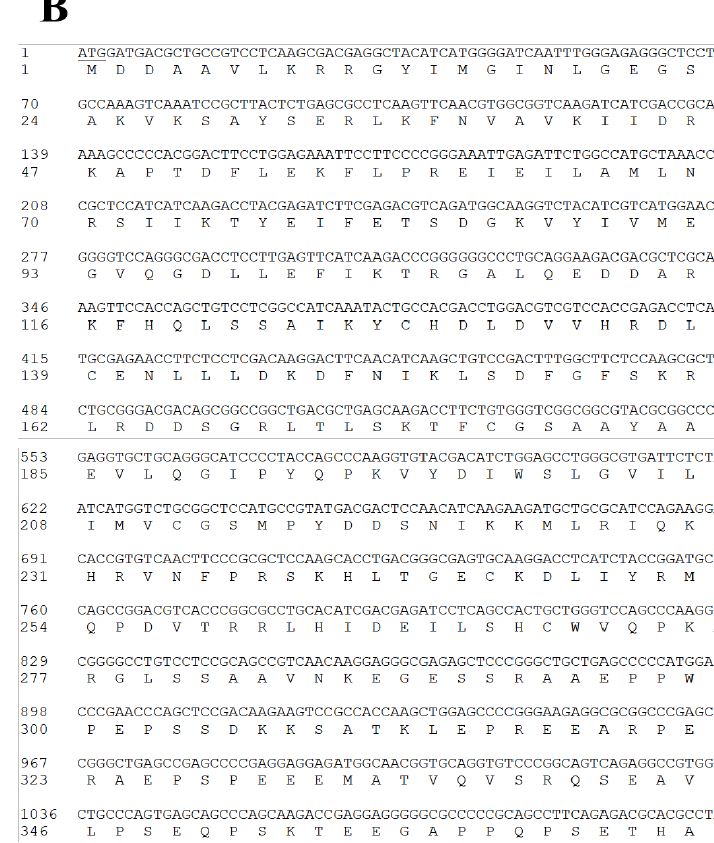
Figure 1. The sequence analysis of yak TSSK1B gene. ( A ) The agarose gel electrophoresis of TSSK1B amplification product obtained from adult yak testis. ( B ) The predicted coding protein sequence generated by ORF of yak TSSK1B . The underline represents the initiation codon, and the asterisk “*” denotes the termination codon.